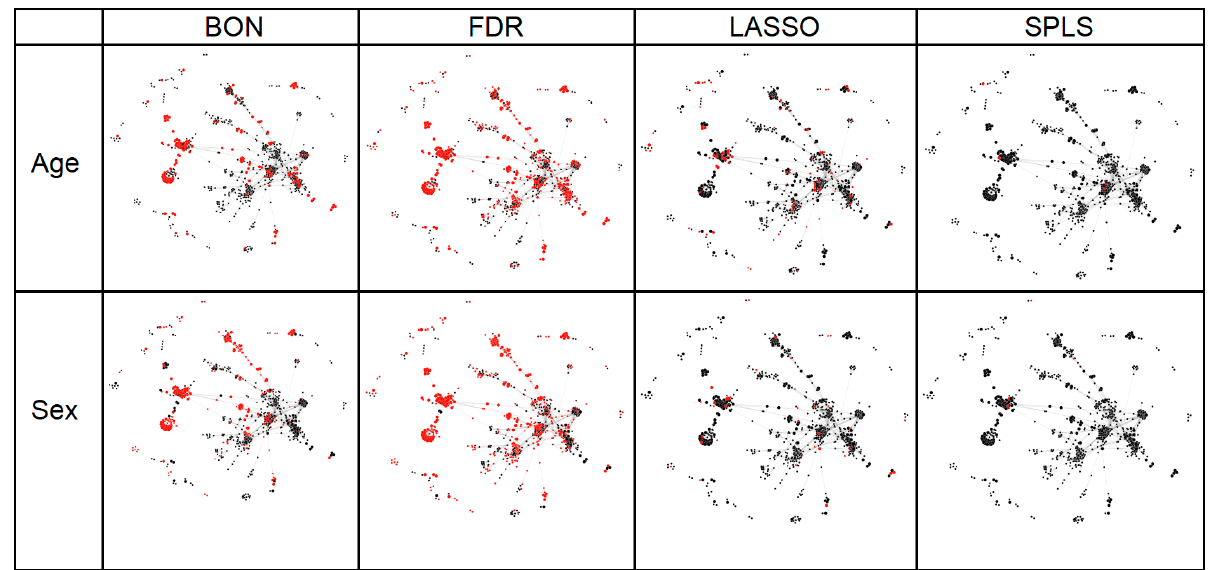
Figure 4. Putative network distribution of metabolites identified by different methods used to analyze cohort-based metabolomics data. The number of metabolites found in association with age (continuous outcome) and sex (binary outcome) from experimentally derived metabolomics studies (see text) for the different statistical methods applied was greater for traditional than for statistical learning models. Notably, the former identified metabolites that tended to be highly correlated with each other (Spearman rho ≥ 0.65), whereas the latter identified a more parsimonious number of metabolites distributed across the putative network of all highly intercorrelated metabolites. BON, Bonferroni; FDR, false discovery rate; LASSO, least absolute shrinkage and selection operator; SPLS, sparse partial least squares.